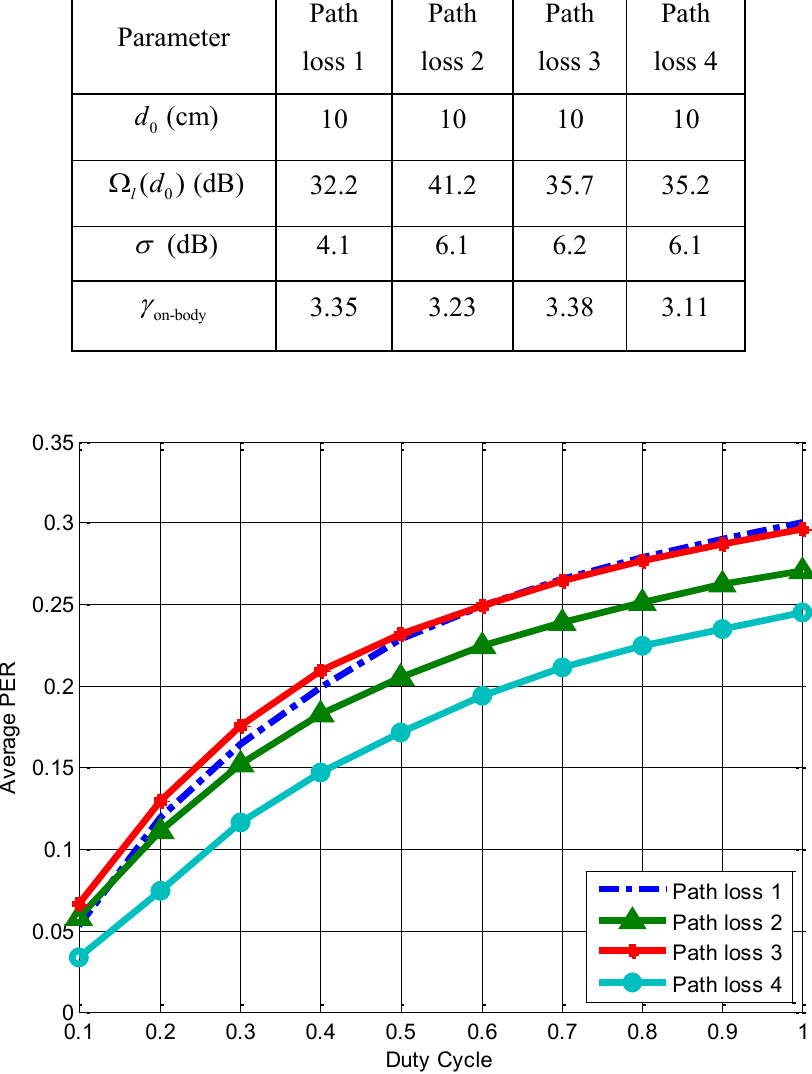
Table 4. The parameter settings of the path loss model in case study. TABLE III. O N - BODY P ATH L OSS M ODEL S ETTINGS